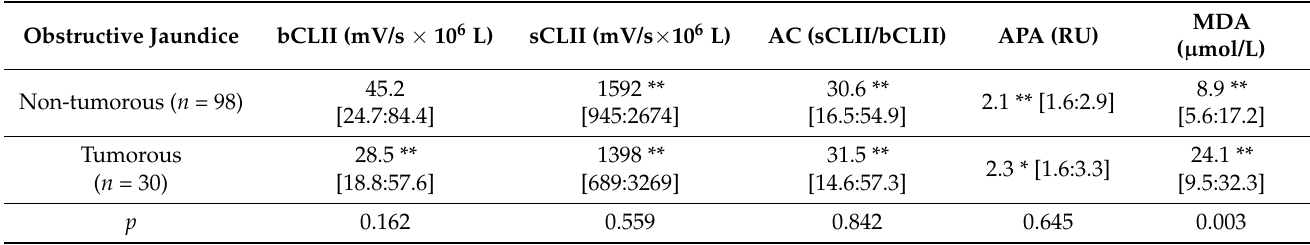
Table 3. Indicators of free radical processes in patients with jaundice of a tumorous or non- tumorous etiology.